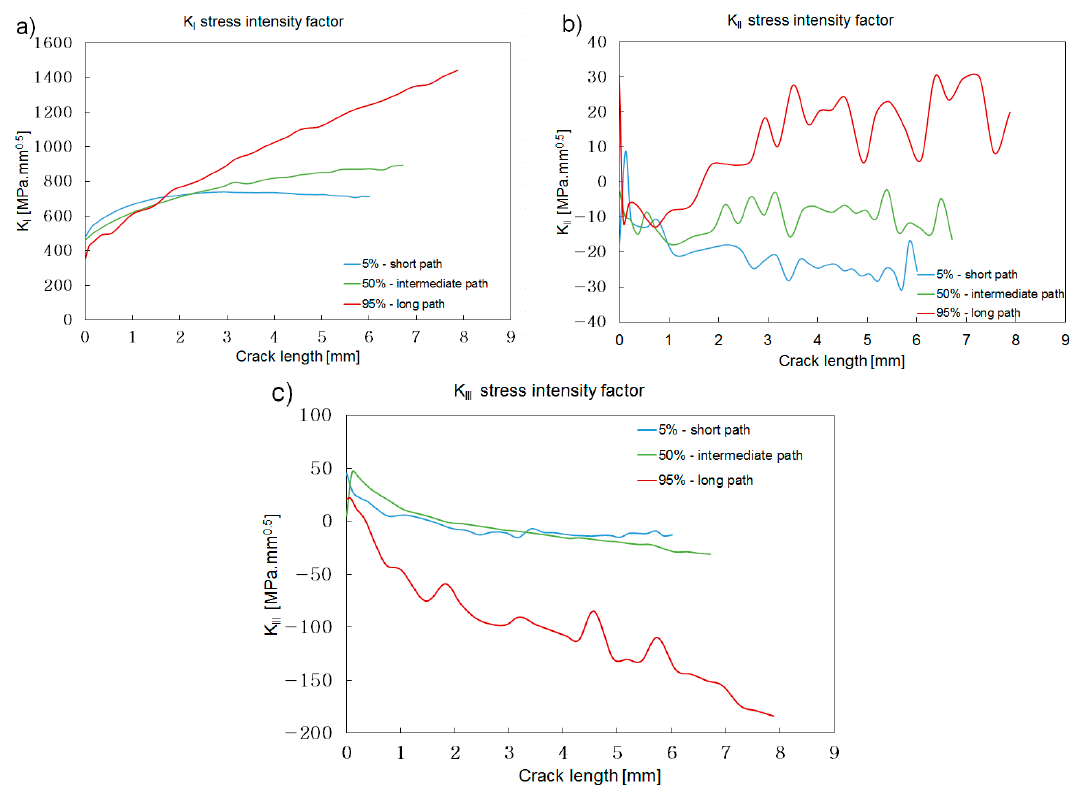
Figure 18. The 60° long flank. Stress intensity along the three crack paths selected: ( a ) K I ; ( b ) K II ; ( c ) K III .